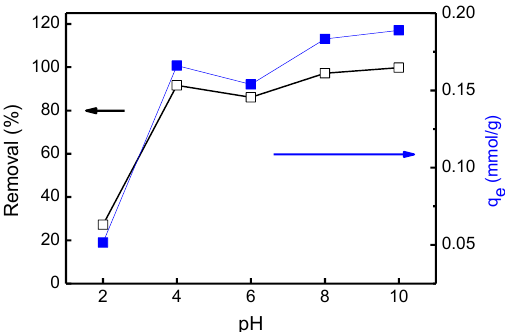
Figure 4. Changes in removal efficiency and adsorption capacity of AERs for EDTA at various pHs. [EDTA] = 0.5 mM; [AER] = 2 g/L; adsorption time = 5 h.